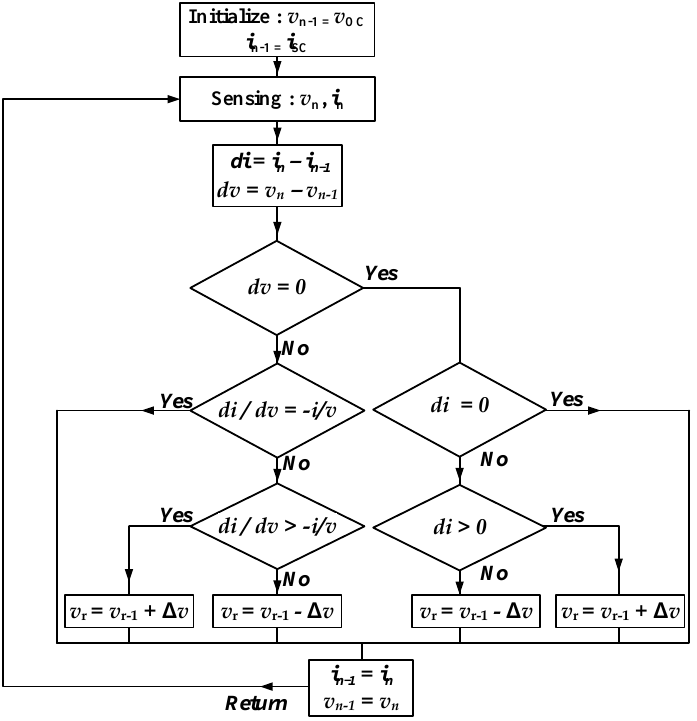
Figure 6. Algorithm Diagram of InCond (Incremental Conductance) Method for Maximum Power Point Tracking.